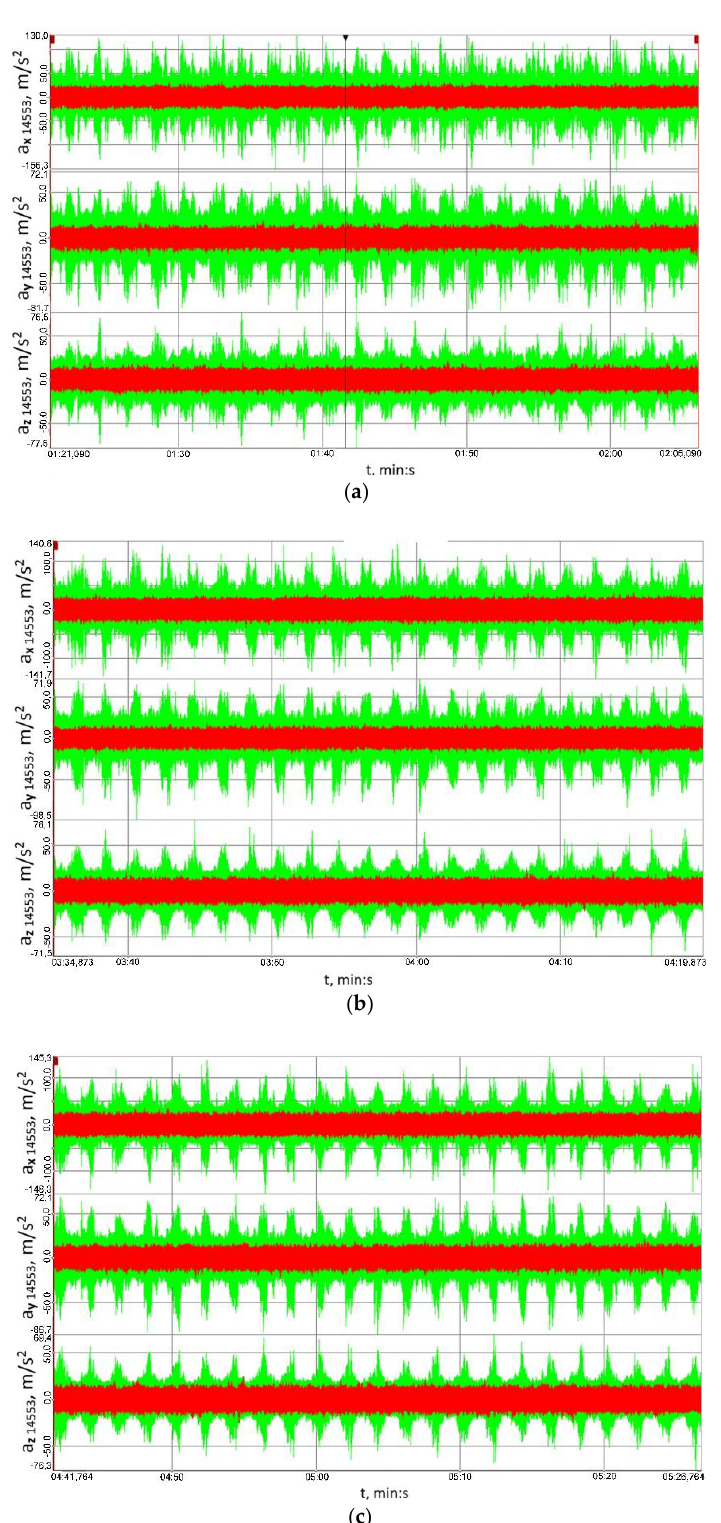
Figure 12. Time histories of the vibration accelerations recorded in three mutually perpendicular measurement directions using transducer No. 14519 (Figure 7) attached to the housing of the output shaft bearing in the multi-stage reduction gear: ( a ) 41.8 ± 27.9 Nm, ( b ) 79.2 ± 55 Nm, ( c ) 114.8 ± 75.9 Nm; red colour marks the results obtained for the flexible operation mode of the clutch; green colour corresponds to the locked operation mode.